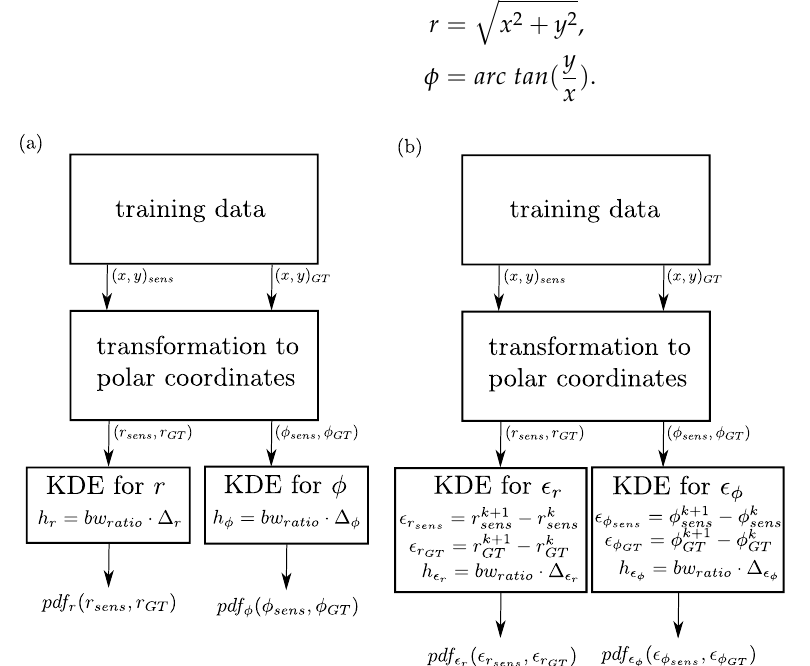
Figure 3. Workflow of developing the polar coordinate sensor model ( a ) and the inertia sensor model ( b